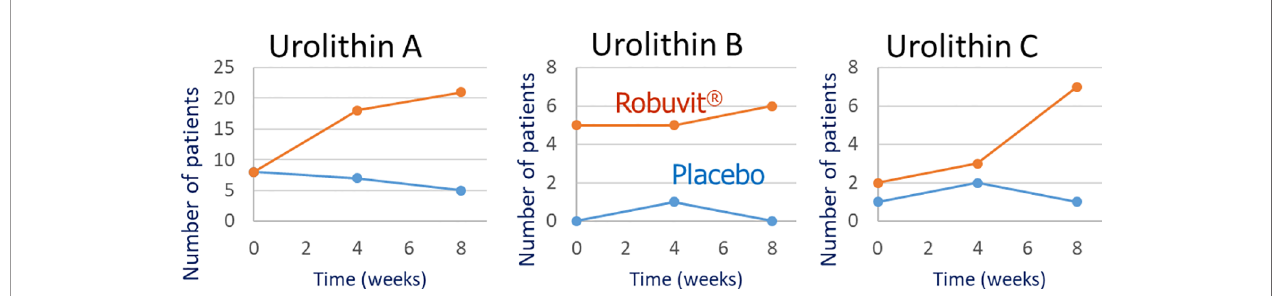
FIGURE 4 | Number of patients in the Robuvit ® and placebo group with detectable urolithin (A – C) concentrations in serum samples from baseline (t= 0) until the end of the study